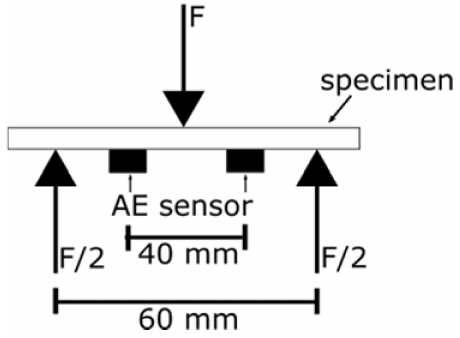
Figure 1. Testing setup for three-point bending with in-situ acoustic emission analysis.